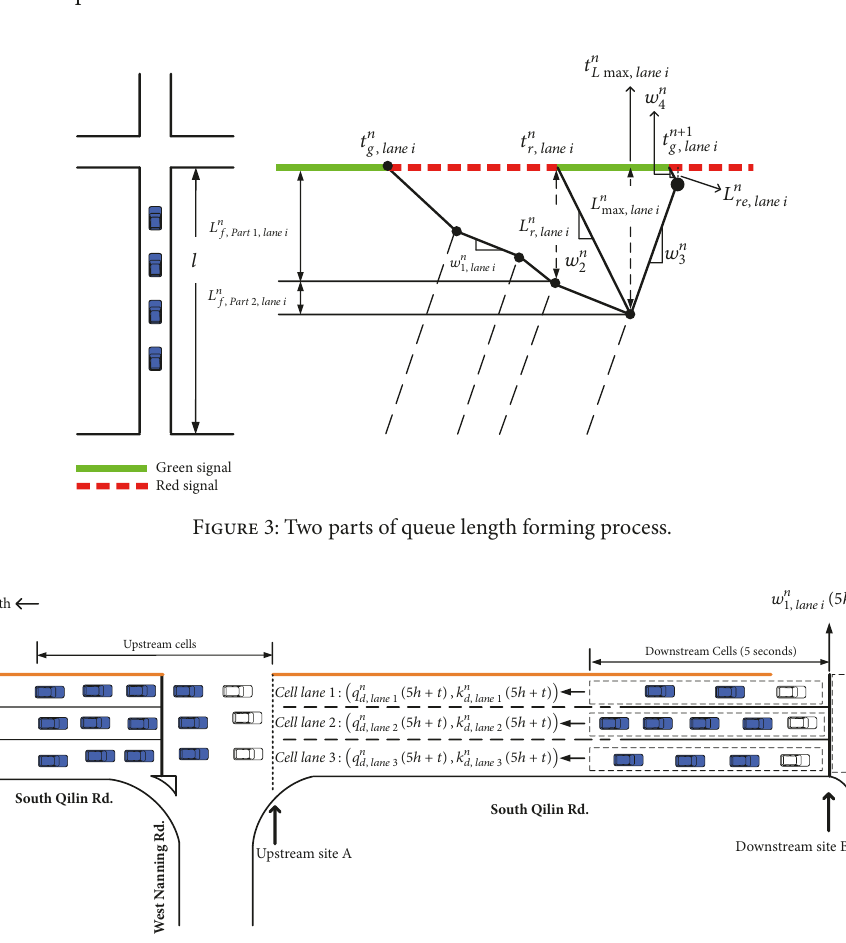
Figure 4: Two adjacent cells of the queue-forming wave (at an interval of 5